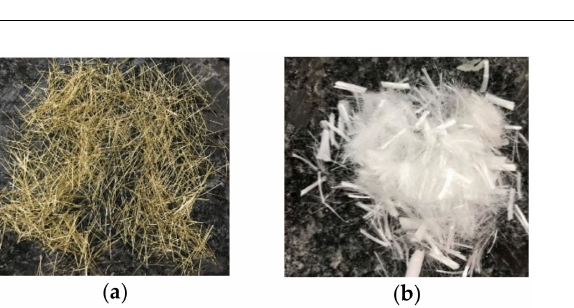
Figure 1. Appearance of ( a ) steel fibers and ( b ) polypropylene fibers.